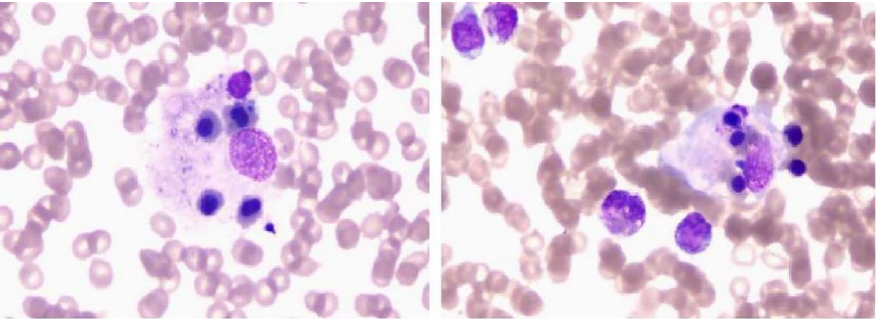
Figure 2. Bone marrow biopsy showed hemophilic cells that engulf leucocytes and nucleated red blood cells. Table 2. Eight of the diagnostic criteria for